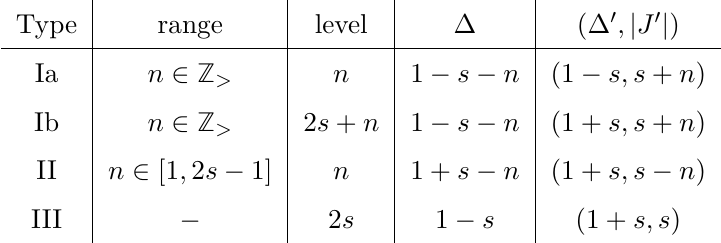
Table 10. Primary descendants of radiative fields with | J | = s . We can only have non-zero wavefunctions if | J 0 | ≤ s , hence the type I descendants are trivially null. We thus see that all of the nontrivial descendants of radiative primaries are at ∆ 0 = 1 + s